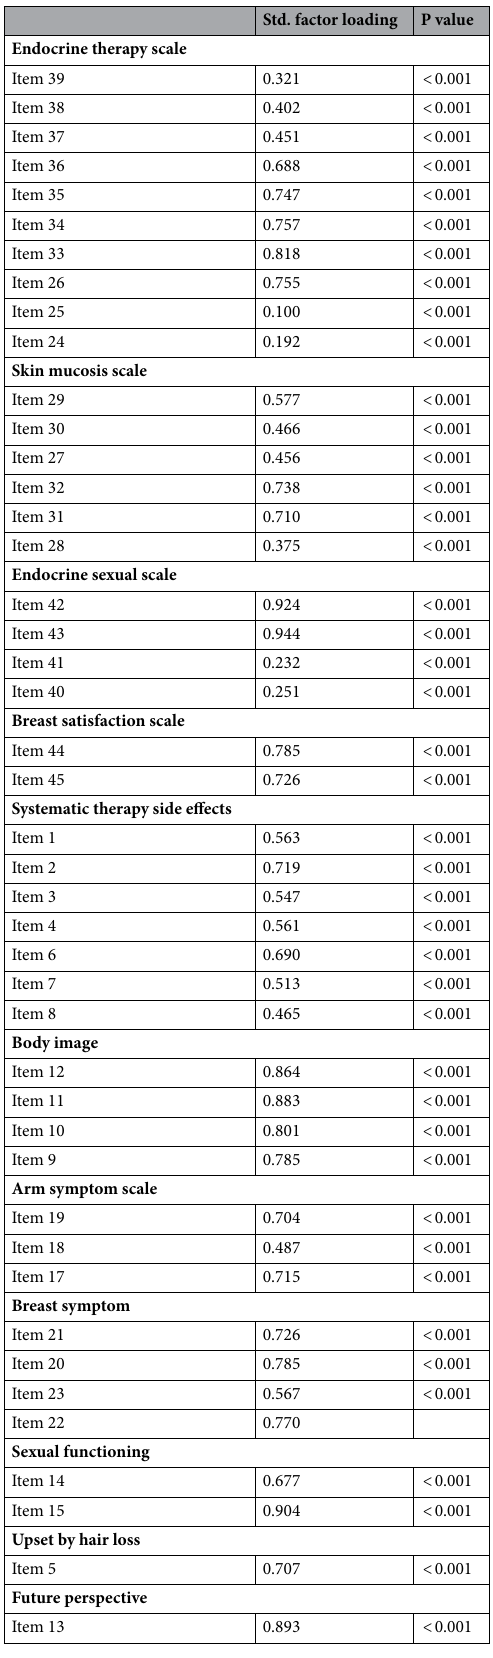
Table 6. Standardized item factor loadings for EORTC QLQ BR45 model Amharic version among breast cancer patients in Ethiopia,